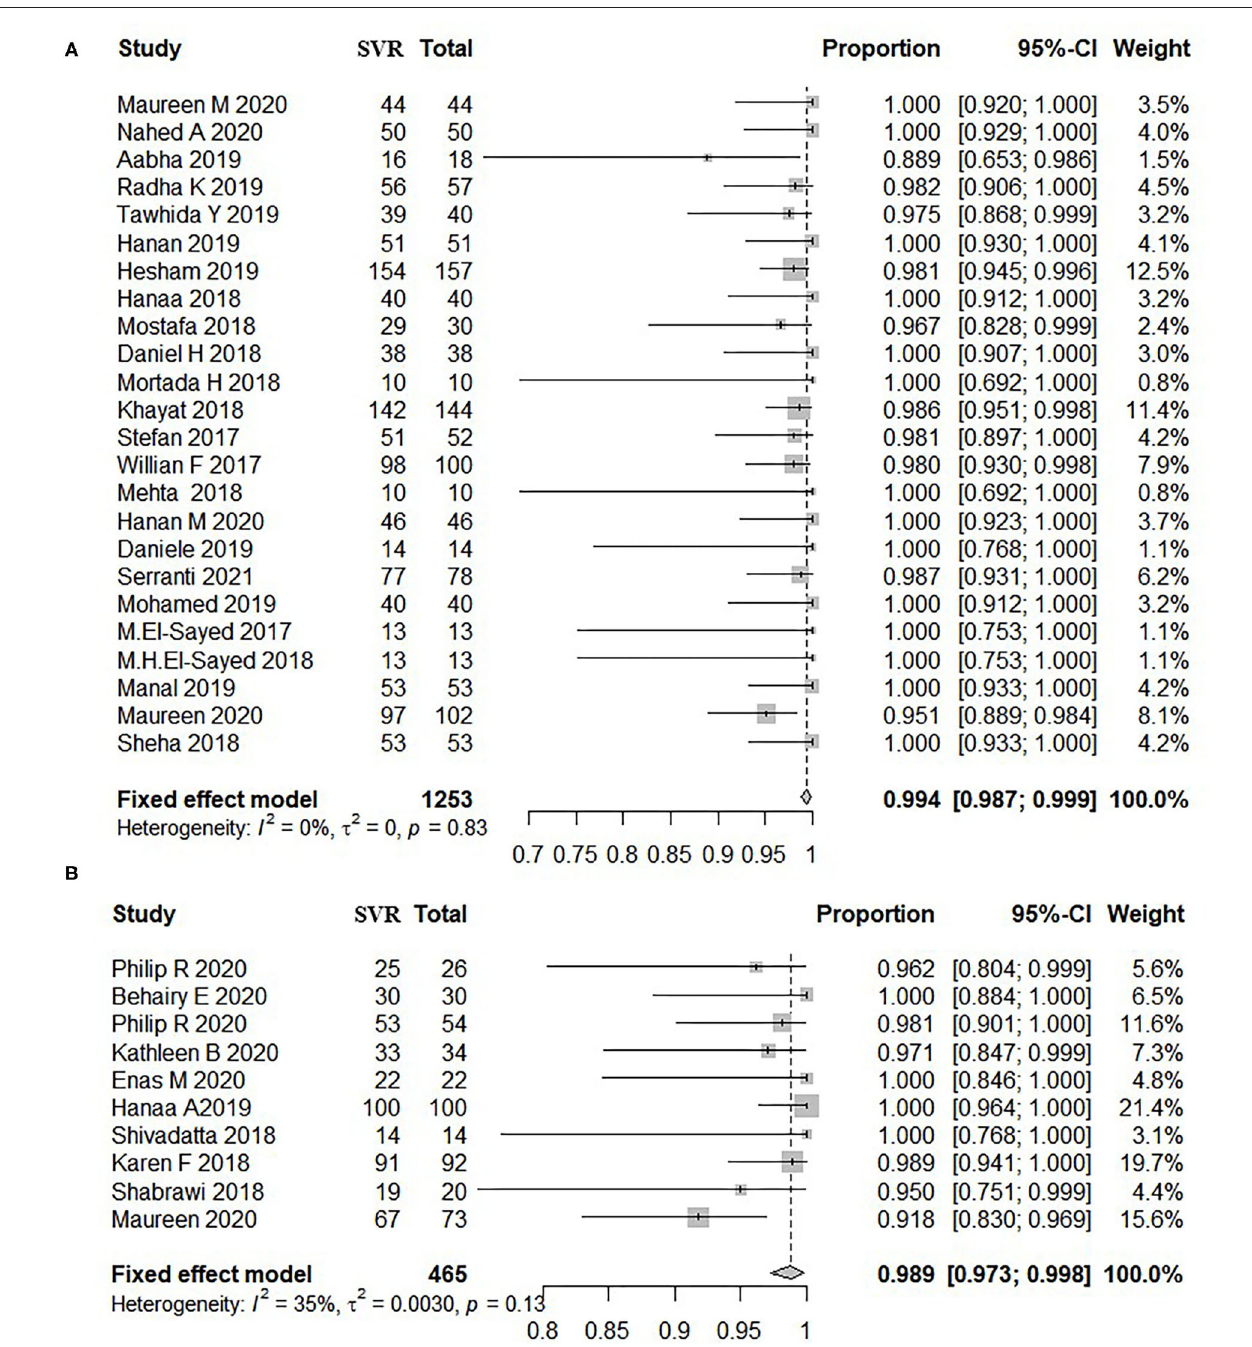
FIGURE 2 | Overall rate of SVR12 in patients treated by DAAs. (A) Patients aged 12–17 years old. (B) Patients below 12 years old. The size of the square represents the weight of the study in the meta-analysis; the line width represents the 95% confidence interval of the study; the vertical line represents the “no effect line”; the diamond-shaped block represents the combined effect estimate of each study (fixed effect model or random effects model). (A) Patients aged 12–17 years old. (B) Patients below 12 years old. SVR, sustained virological response; DAAs, direct-acting antivirals; CI, confidence interval; Total, sum of patients treated by DAA.